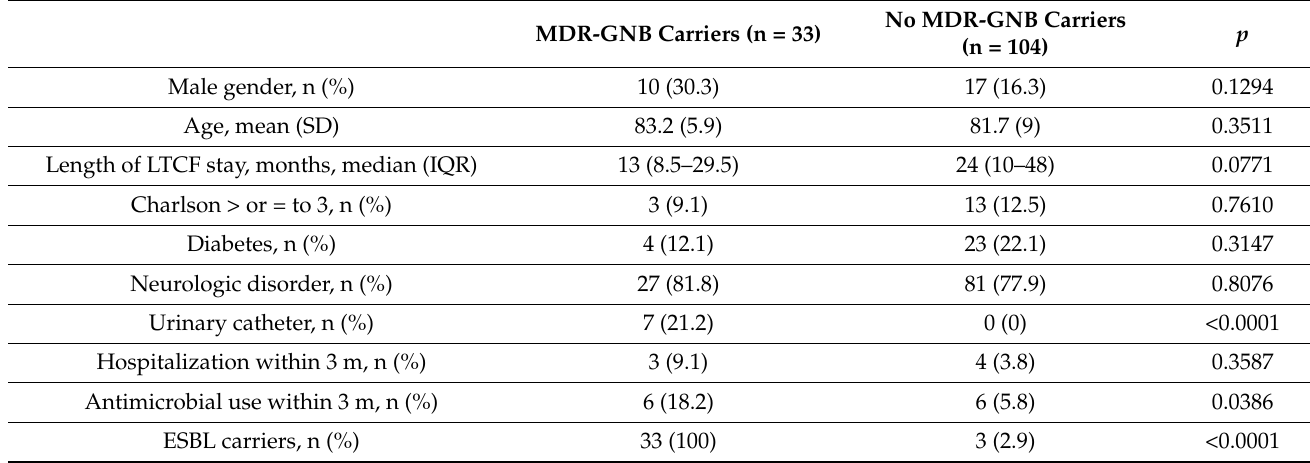
Table 4. Characteristics of LTCF residents regarding colonization by MDR-GNB.